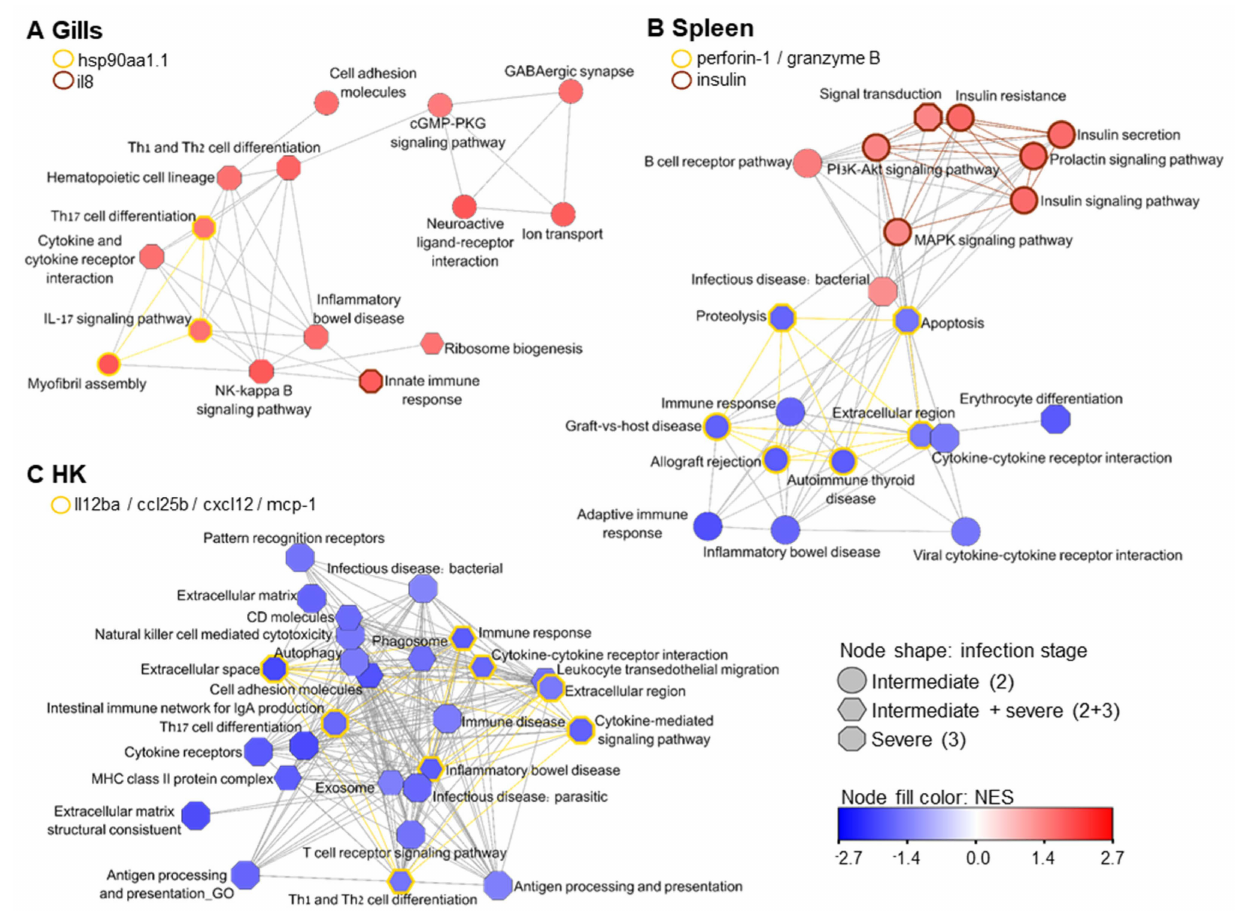
Figure 4. Network analysis for enriched processes (GO/KEGG pathways) based on shared genes. ( A ) Enriched processes in the gills were clustered according to the state of the infection. Intermediate infection are enriched with nervous and muscular-related terms that are linked to severe infection showing enrichment of a cluster of immune-related terms. ( B ) Enriched processes that are related to immune function or signaling are presented for the spleen. ( C ) Immune-related processes in HK. Node fill is color-scaled according to mean NES (up-regulated, red; down-regulated, blue), and node shape indicates the infectious stage (see legend). Edge lengths were derived from shared genes between the connected nodes. Border-colored nodes and colored edges (yellow/brown) represent a differentially expressed signaling/effector gene that participates in the process, as each legend details. See Supplementary Table S3 for additional details of the